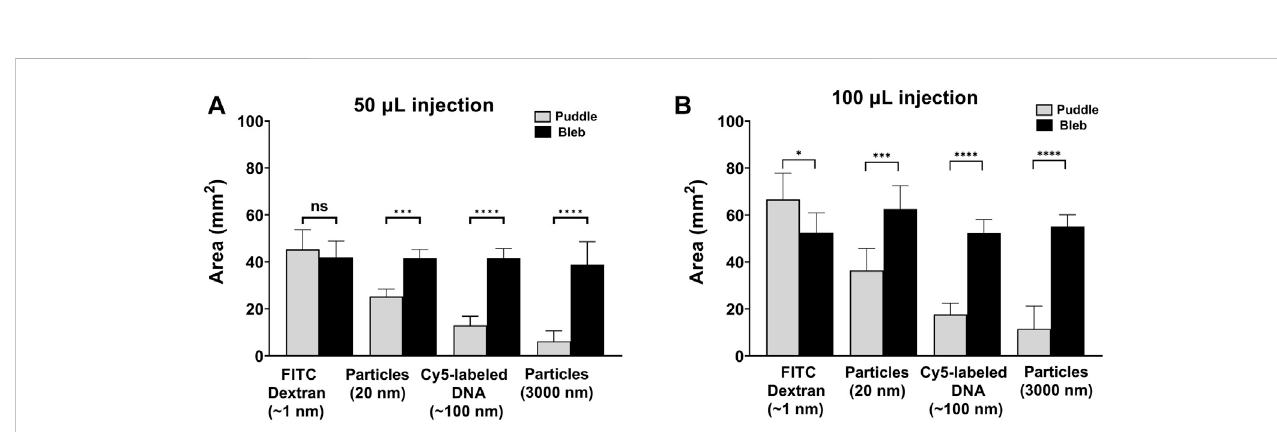
Areaquanti fi cationofthepuddleandthebleb.Areasofthepuddleandblebusing (A) 50 µLand (B) 100 µLinjections. n= 6each.Datarepresentsmean± SD. * p ≤ .05, ** p ≤ .01, *** p ≤ .001, and **** p ≤ .0001 by Student ’ s t-test.